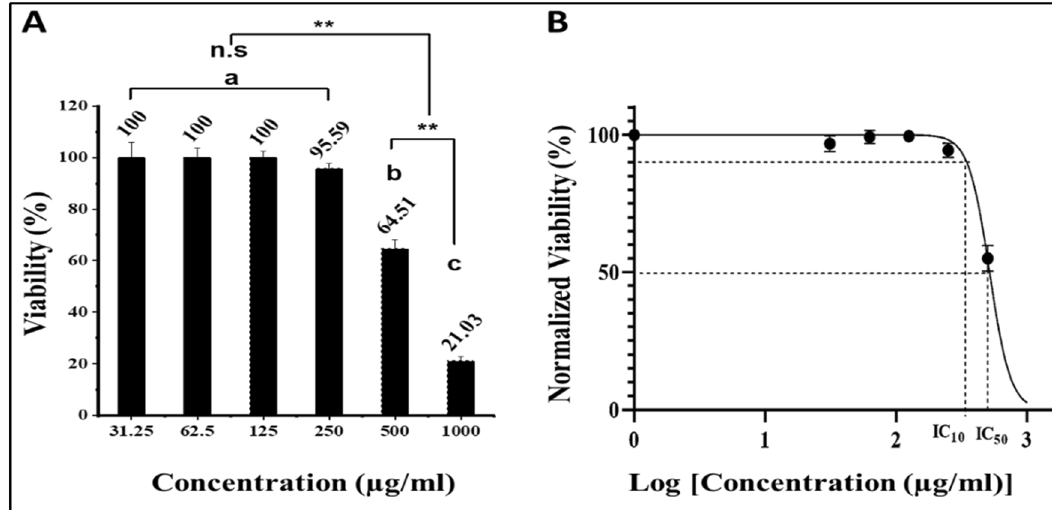
Figure 9. MNTD estimation of Kocuria sp. RAM1 carotenoids. ( A ) Cytotoxicity on normal Vero cells . The letters a, b and c represent significant differences among different homogeneous subsets identified by the post